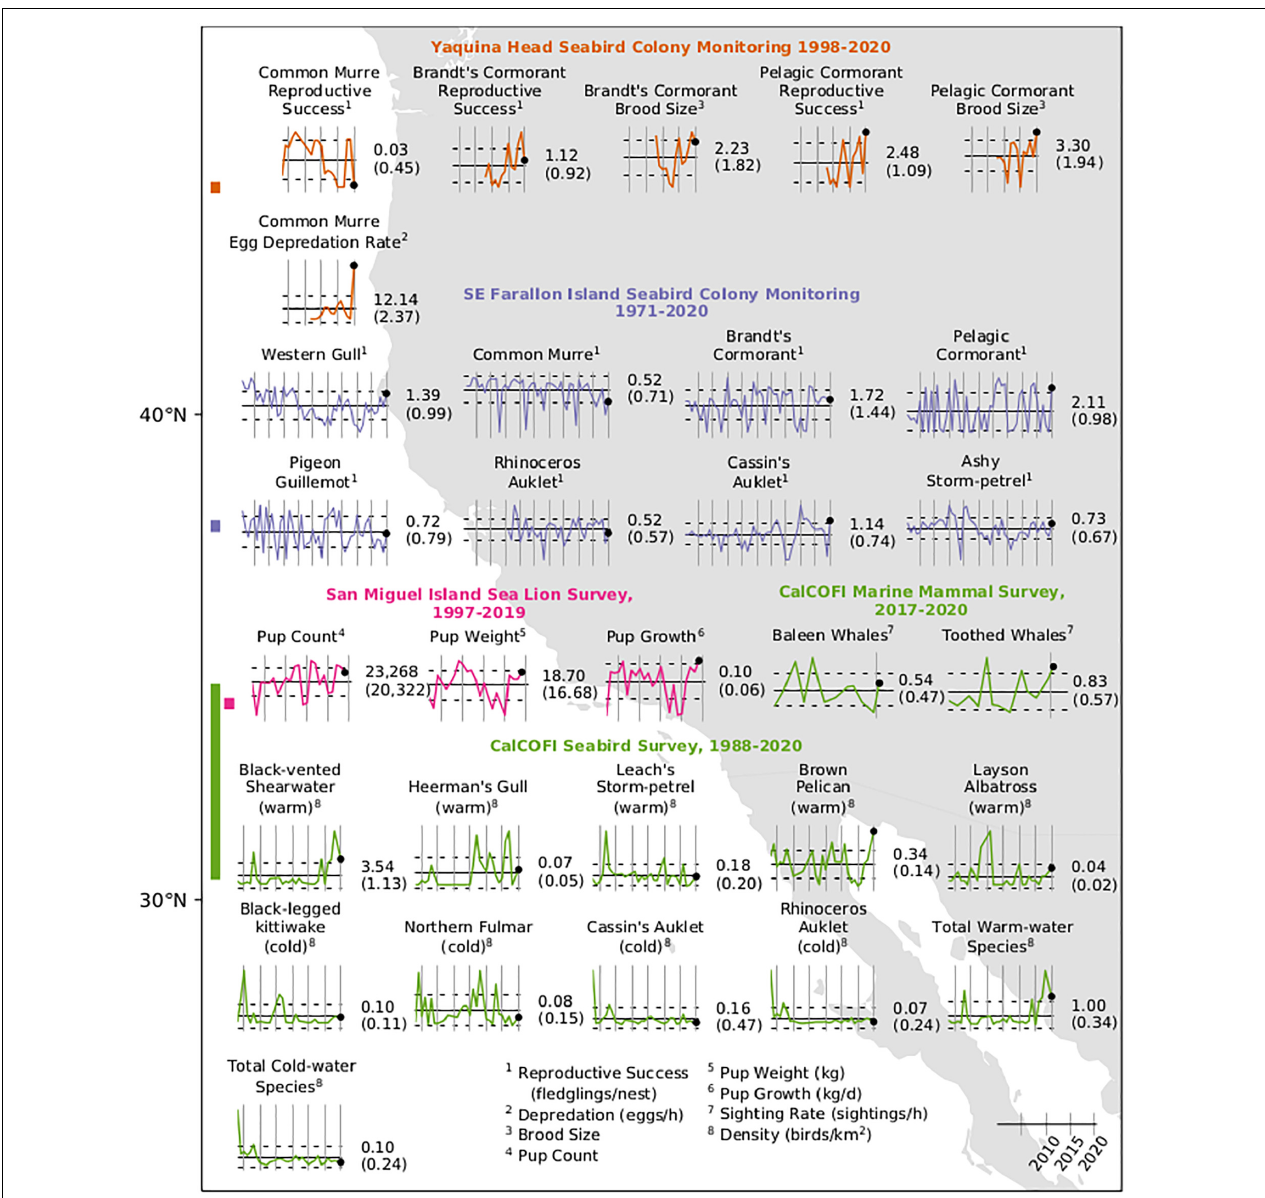
FIGURE 13 | Time series of abundance or condition of seabirds and marine mammals as measured by biological surveys in the CCS. Bars at left indicate the latitudinal sampling range of the surveys with colors corresponding to graphed data. Numbers to the right of each series indicate the value of the final measurement (black dot) and long-term mean (horizontal bar) in parentheses. Vertical bars are at 5-year intervals with the right-most bar at January 1, 2020. Dotted lines indicate ± 1